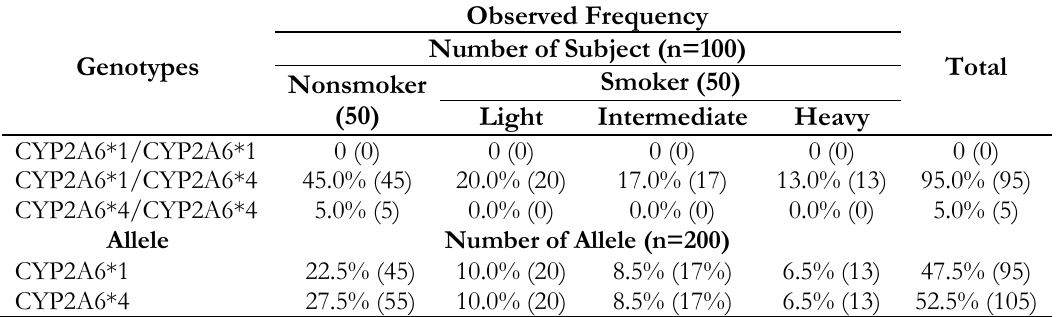
Figure 1. Electrophoregrame PCR product and Digested product identification of CYP2A6*1 and CYP2A6*4 allele. M1: Marker DNA Ladder, A: Isolated DNA, B: PCR Product (1358/1356bp), C: Digested Product (728bp) and D: Digested Product (824bp and 728bp), M2: Marker DNA ladder. Table II. CYP2A6 genotype and allele frequencies in the Javanese Indonesian according to smoking